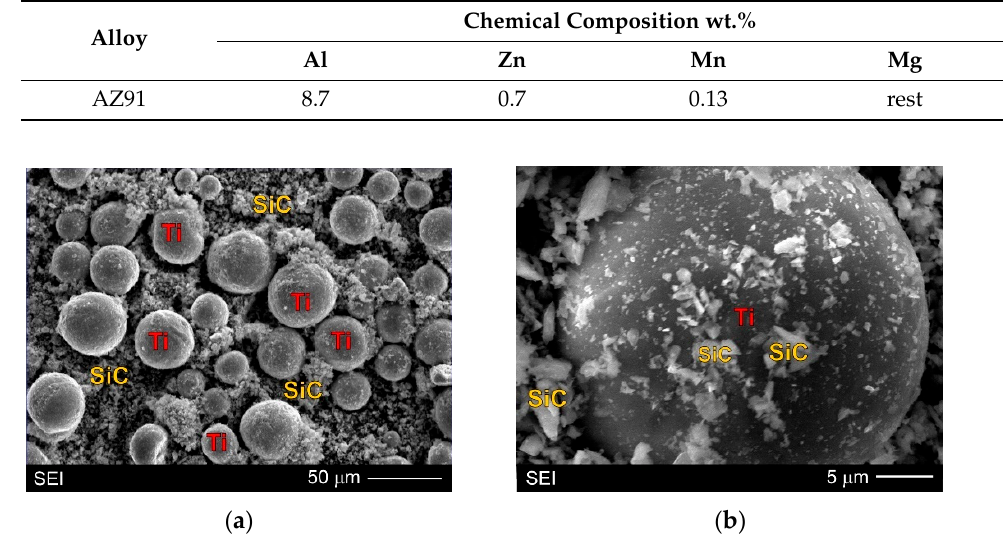
( b ) Figure 4. Microstructure of unreinforced AZ91 matrix alloy: ( a ) SEM micrograph; ( b ) Higher magnification of area marked as X on ( a ) micrograph with EDX results obtained from designated points.